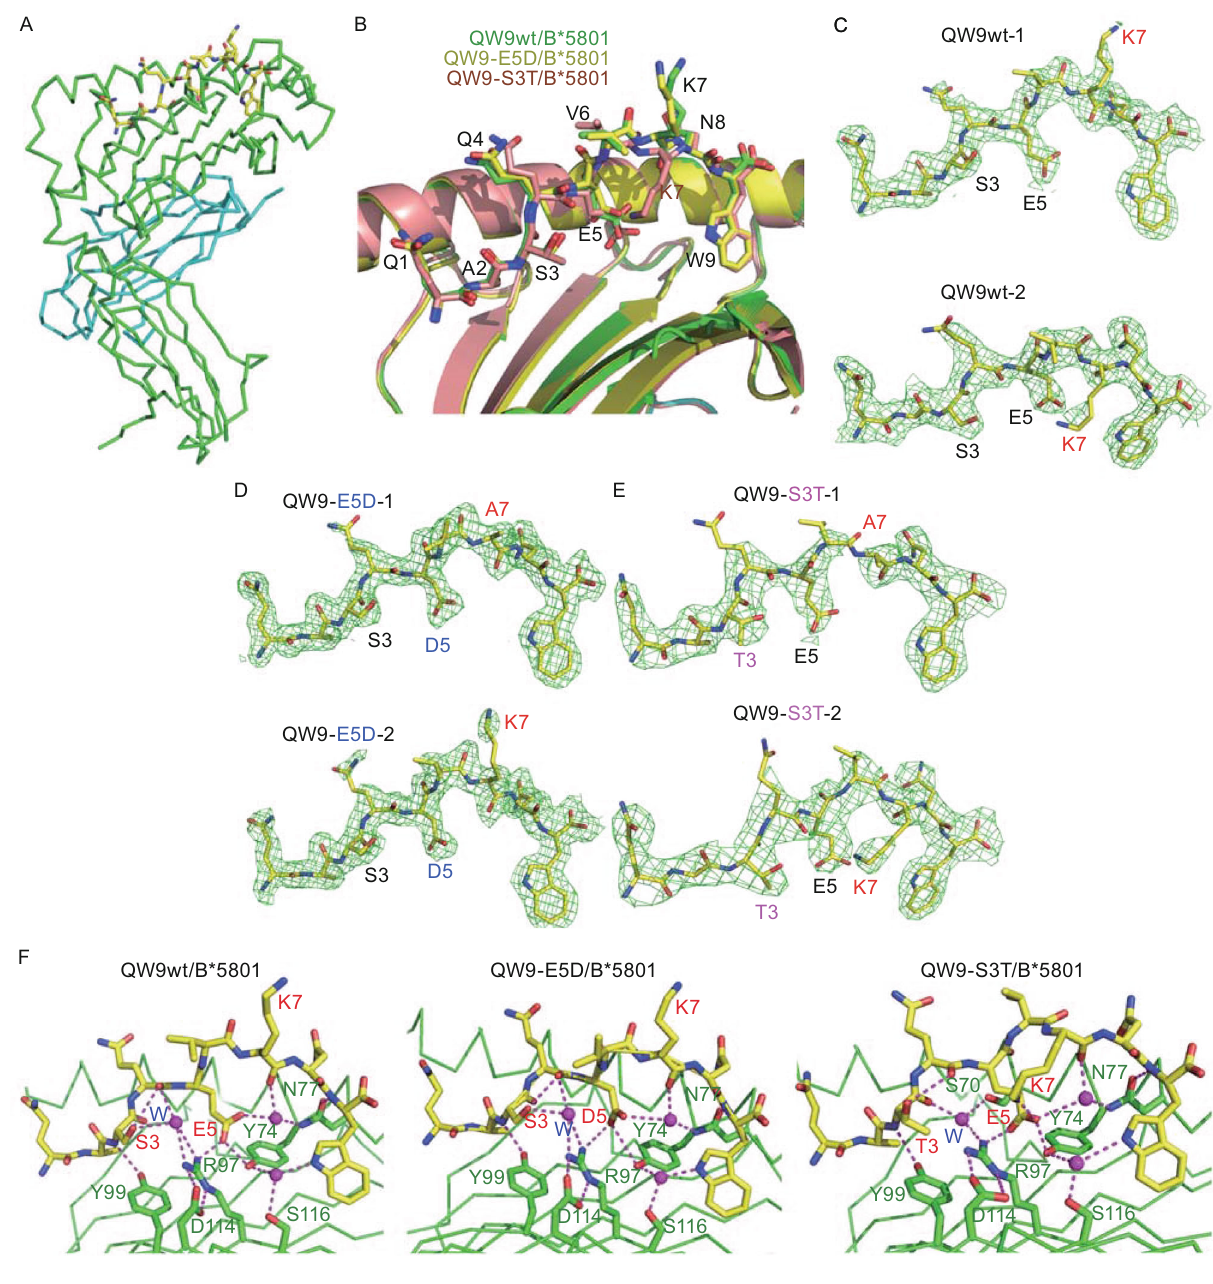
Figure 1. Structures of HLA-B*5801 complex with QW9 and its variants . (A) Overall view of the structure of QW9wt/HLA-B*5801. The heavy chain is in green and the β 2m domain is in cyan. The peptide QW9wt is in a yellow stick model. (B) Overlay of structures of HLA-B*5801 loaded with wild-type QW9 and its variants, E5D and S3T. The front helix of HLA has been removed for clarity. (C – E) The 2Fo-Fc difference maps for the bound peptide only. Shown here are peptides in six independent peptide/HLA-B*5801 complexes of three crystal structures determined. The map is contoured at 0.9 σ level. Note that in Fig. D and E, the densities of QW9-E5D-1 and QW9-S3T-1 are too weak to assign the long fl oppy side chain of K7. Only Ala is modeled instead. But their main chain conformations are in convex shape, indicating that the fl exible side chain of K7 should point outwards. (F) The peptide-binding mode. Shown here is the hydrogen-bonding network between peptide and HLA molecule for three representative structures. Hydrogen bonds are shown in magenta dash lines. The magenta-colored balls are water molecules. HLA-B*5801 and its residues are in green and QW9 is in yellow stick model. The important residues on QW9 and the variants are labeled in red. Again the front helix of HLA has been removed for